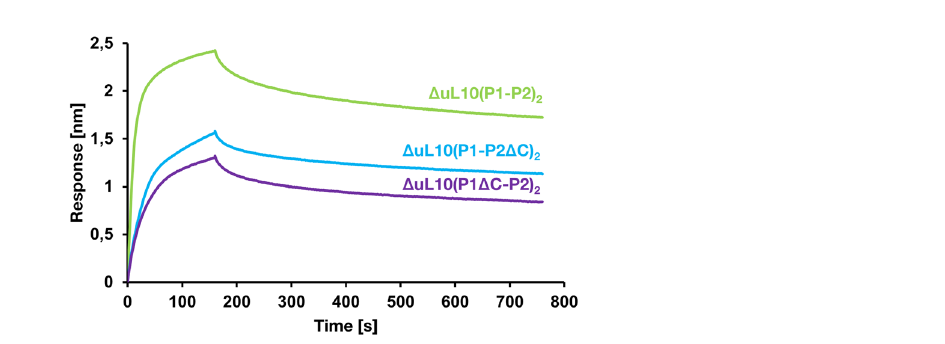
Figure 4. Interaction of RTA with the human ribosomal stalk pentamer complexes. Interaction of RTA with different forms of human stalk pentamer Δ uL10(P1-P2) 2 , Δ uL10(P1 Δ C-P2) 2 and Δ uL10(P1-P2 Δ C) 2 was analyzed by BLI using the OCTET 96 RED system. The His tagged RTA was immobilized on an Ni 2 + - nitrilotriacetic acid (NTA) sensor chip as the ligand and human stalk pentamers were used as the analyte. Representative association/dissociation curves are shown for the stalk complexes at 112 nM. The curves represent the means of three experiments and were obtained by simultaneously fitting the association and dissociation responses to a 1:1 binding